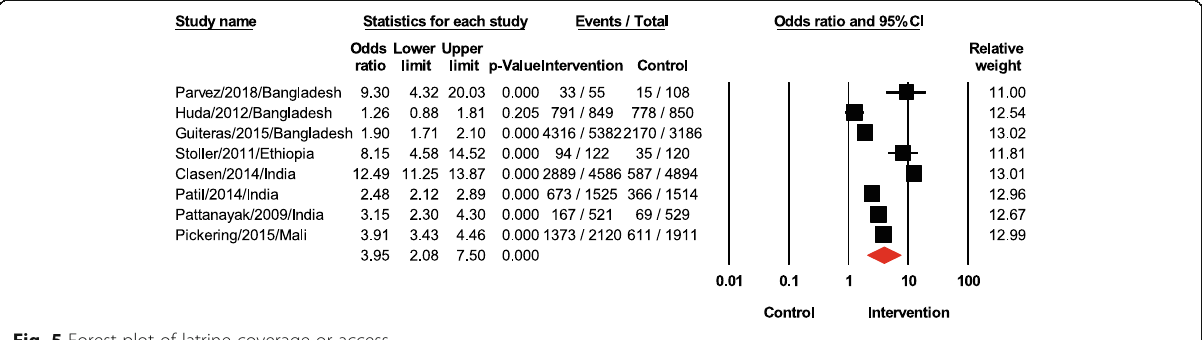
Fig. 5 Forest plot of latrine coverage or